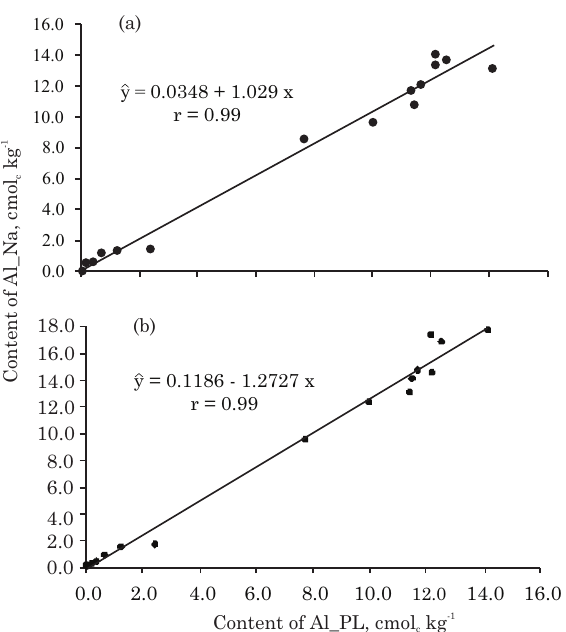
Figure 3. Correlation between aluminium contents determined by ICP-OES (Al_PL) and by titration with NaOH (Al_Na) (a) and by spectrometry with xylenol orange (Al_Na)